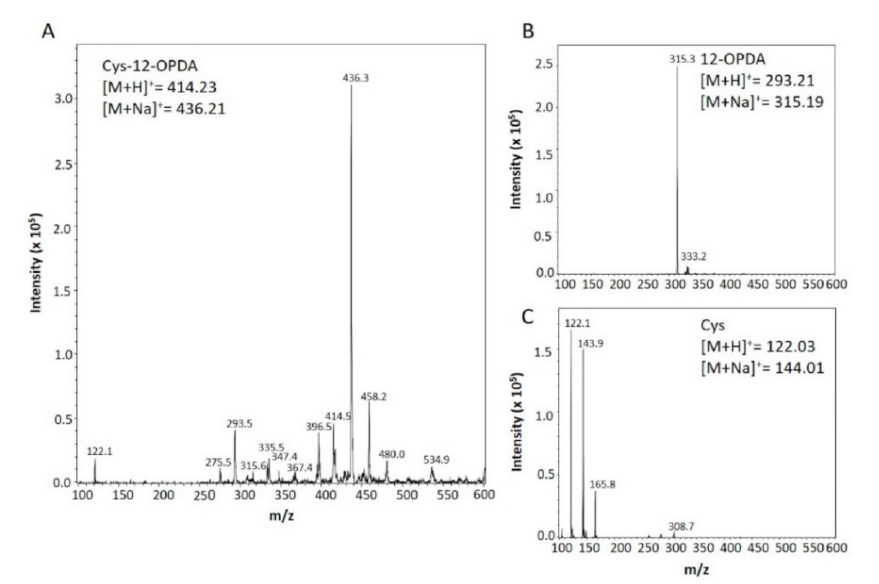
Figure 3. Photosynthetic performance of leaf discs floating on MVK (gray) pre-incubated with GSH or ASC. Changes in quantum yield of photosystem II ( Φ PSII) of A. thaliana (Col-0) in response to treatment with methyl vinylketone (MVK), MVK preincubated with GSH (MVK+GSH) or ASC (MVK+ASC). Leaf discs floated on a solution containing the indicated compounds (500 µ M) in 100 µ M CaCl 2 for membrane stabilization. Φ PSII was determined by chlorophyll a fluorescence analysis using the pulse-amplitude-modulated photosynthesis yield analyzer (Mini-PAM). Data are means ± SD, n = 5. Significant differences at p ≤ 0.05 were calculated using one-way ANOVA with post hoc Tukey HSD and are represented by letters a–c.